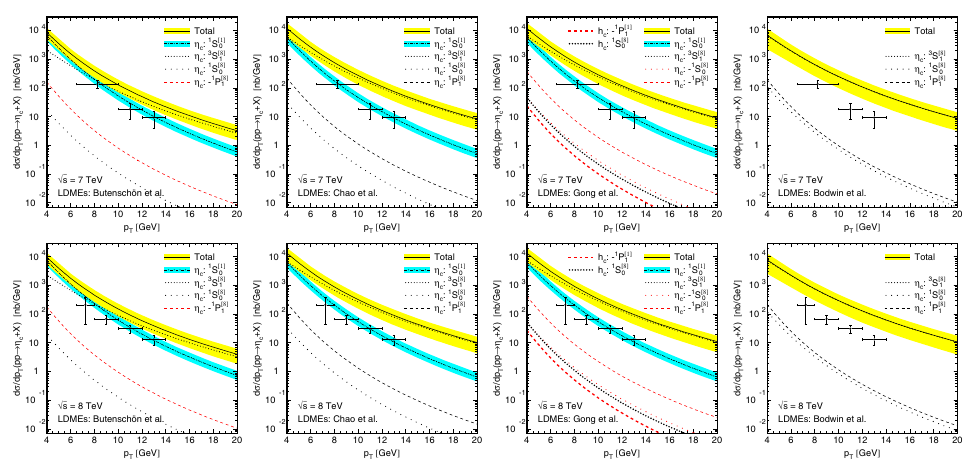
Figure 2. The LHCb [12] measurements of d σ/ dp T for prompt η c hadroproduction at √ s = 7 TeV (upper panel) and 8 TeV (lower panel) are compared with the default predictions of NRQCD (solid lines) and the CSM (dot-dashed lines) at NLO, but without relativistic corrections, evaluated with the four LDME sets in Table 1. The theoretical errors as explained in the text are indicated by the yellow and blue bands, respectively. For comparison, also the default contributions due to the individual Fock states are shown. Red color (minus sign in the legend) indicates negative